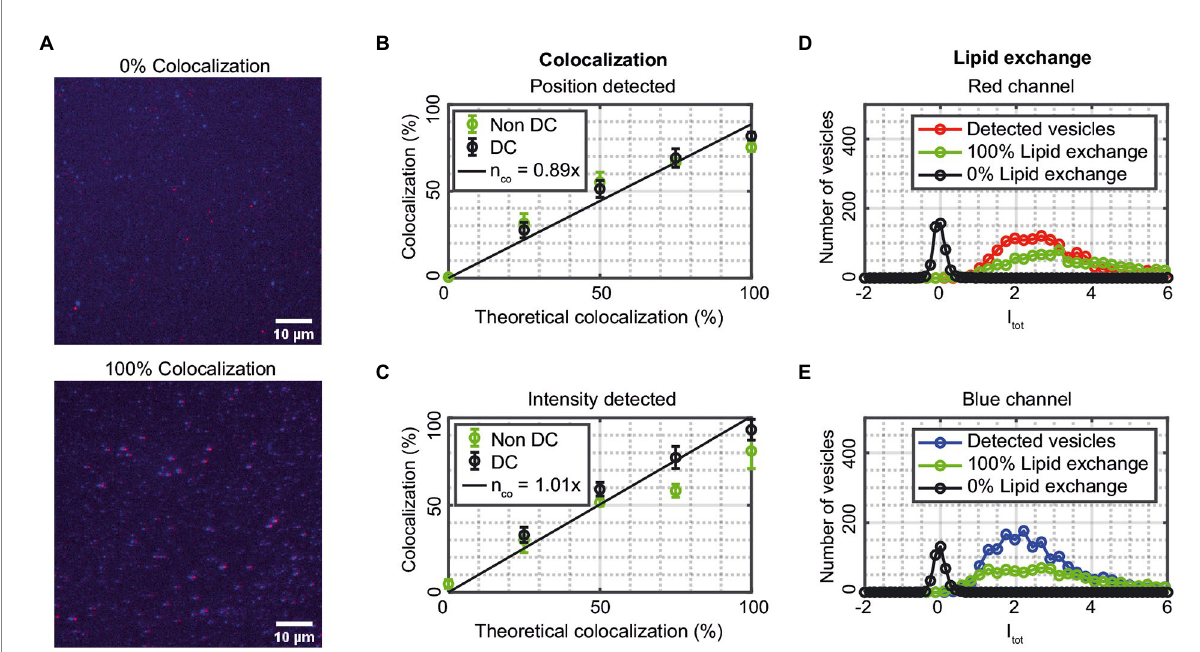
FIGURE 5 (A) Fluorescence images of two samples of vesicles, either all vesicles are blue or red (0% colocalization) or all vesicles are both blue and red (100% colocalization). The red and blue channels are merged, and the scale bars are 10 μ m. (B,C) The measured colocalization as a function of theoretical colocalization for data that is not drift corrected (green) and data that is drift corrected (black). The data corresponds to mean ± SD from n = 3–5 measurements. The solid lines are linear fits to the drift corrected data. (D,E) The integrated intensity I tot (Eq. 4) distribution for the vesicle population collected from 1 to 3 measurements. Detected vesicles correspond to vesicles that are detected in the red (blue) channel and 0 and 100% lipid exchange refers to values when the mask from the blue (red) channel is applied to the red (blue) channel for samples with 0 and 100% lipid